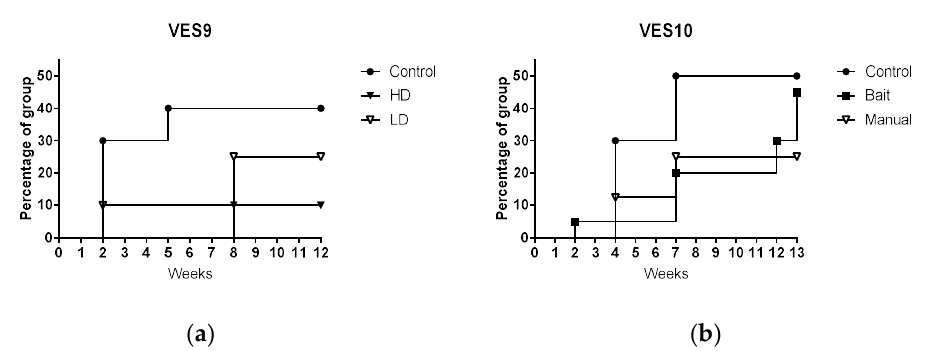
Figure 2. Survival curves showing the percentage of each treatment group in study VES9 ( a ) and study VES10 ( b ) excreting M. bovis in any clinical sample at the time that the first positive culture was produced. Controls = unvaccinated badgers. HD = manual vaccination with 1.2 × 10 9 colony forming units (CFU) of Bacillus of Calmette and Guérin (BCG). LD = manual vaccination with 2.0 × 10 8 CFU BCG. Bait = vaccinated with 8.6 × 10 8 CFU BCG by voluntary consumption of BCG in bait. Manual = manual vaccination with 8.4 × 10 8 CFU BCG.